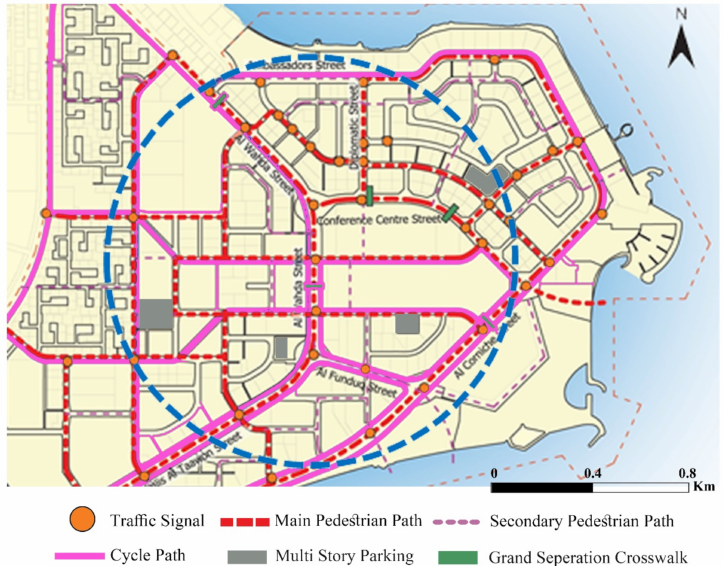
Figure 15. Connectivity and Walkability Existing and